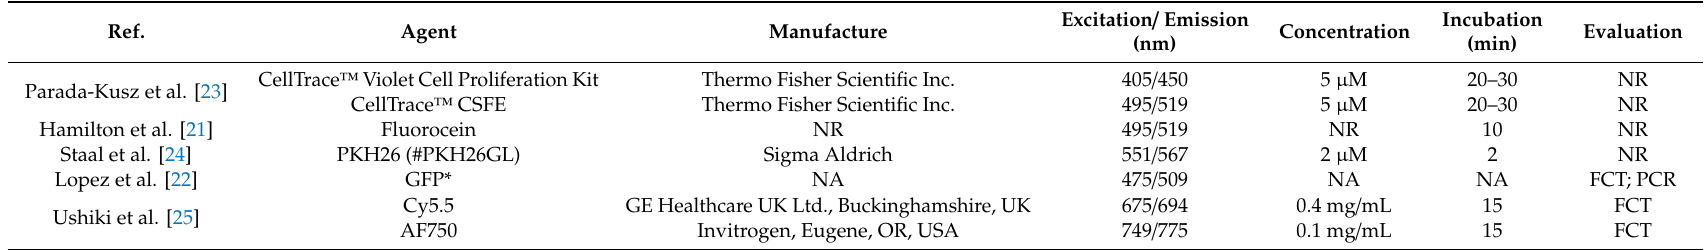
Table 4. Labeling of hematopoietic stem cells with